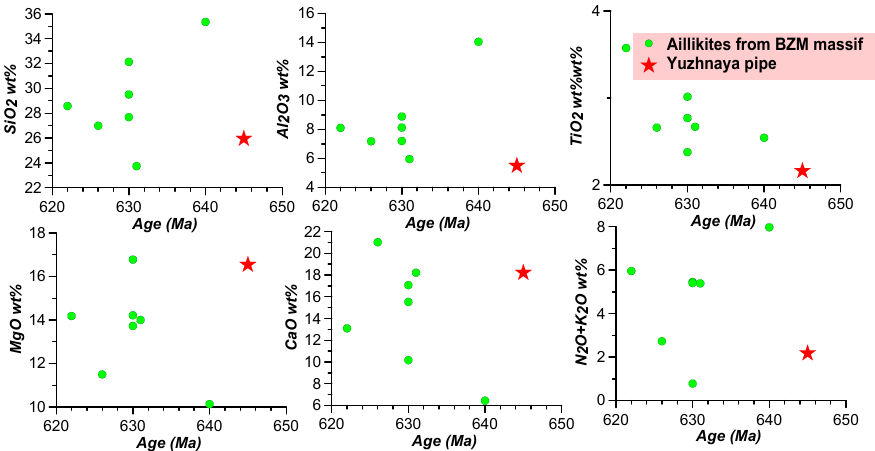
Figure 11. Variation of chemical composition with 40 Ar/ 39 Ar age for BZM aillikites.